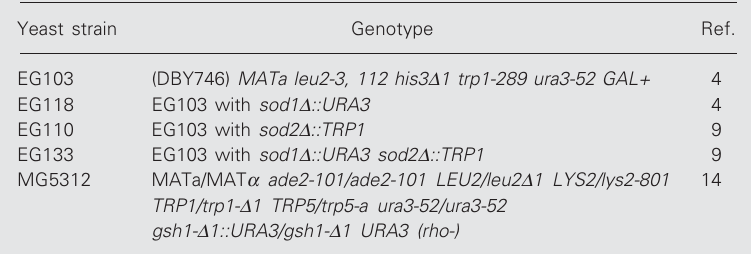
Table 1. Yeast strains used in this